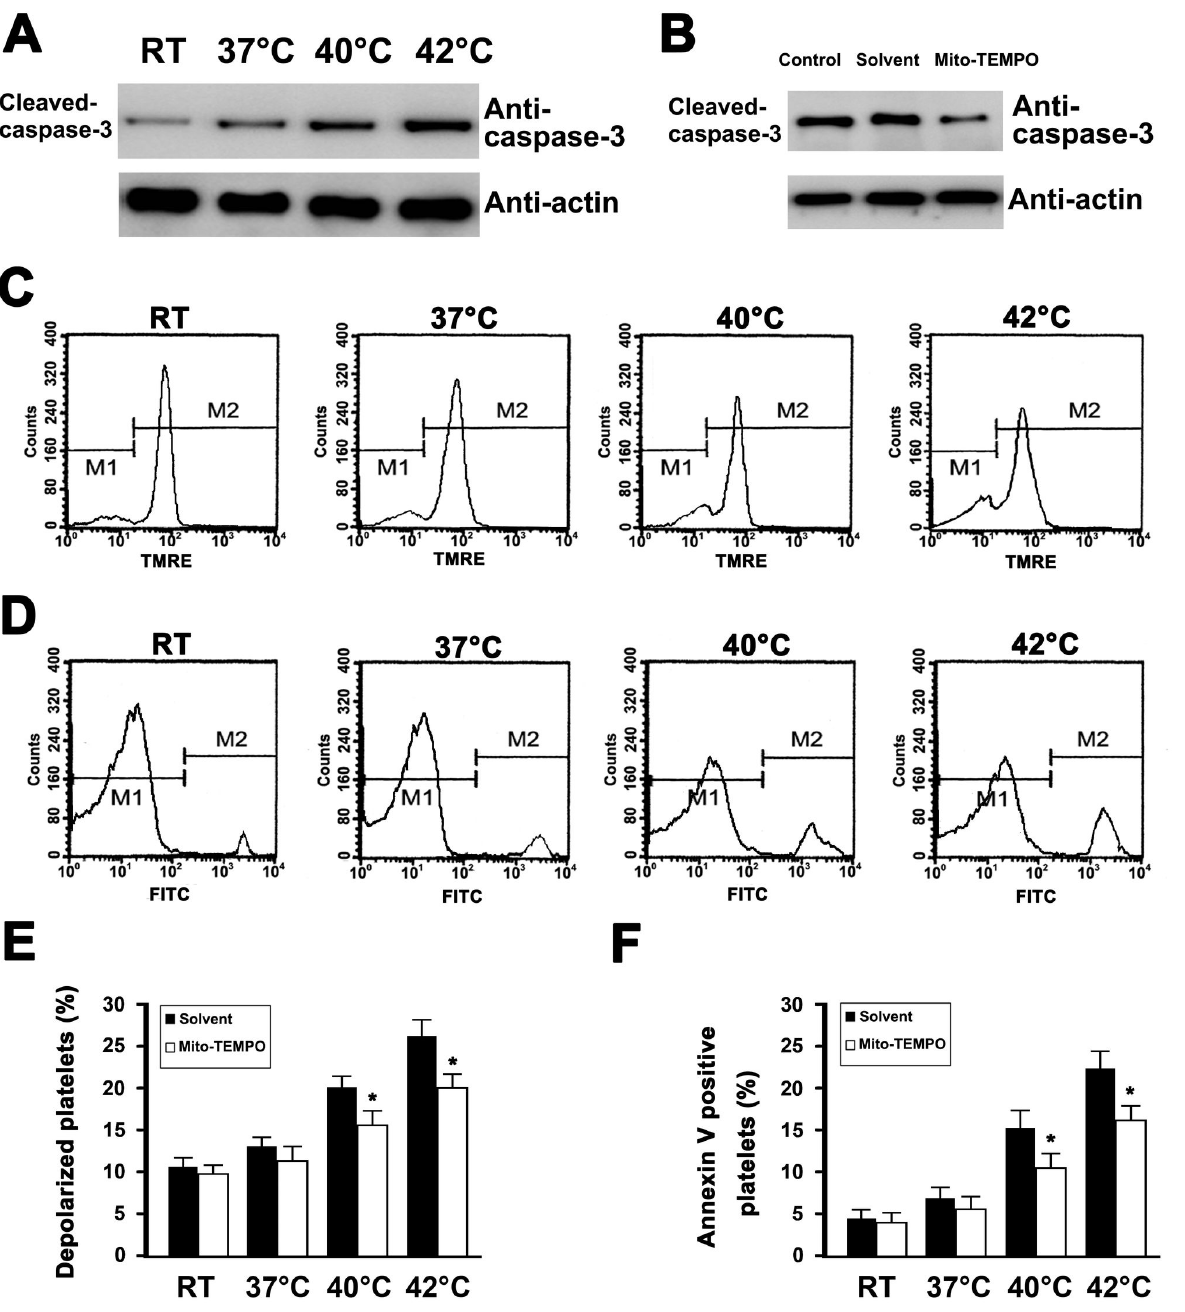
Figure 5. Effect of Mito-TEMPO on caspase-3 activation, depolarization of ΔΨm, and PS exposure in hyperthermia-treated platelets. (A and B) Washed platelets were incubated at indicated temperatures for 3 h (A) or pre-incubated with Mito-TEMPO and solvent control at 37°C for 15 min and then incubated at 42°C for 3 h (B). Treated platelets were lysed and analyzed by Western blot with anti-cleaved p17 fragment of caspase-3. Actin levels were assayed to demonstrate equal protein loading. Representative results of three independent experiments are presented. (C–F) Washed platelets were pre-incubated without (C and D) or with Mito- TEMPO and solvent control at 37°C for 15 min (E and F), and then incubated at the indicated temperature for 3 h. Treated platelets were incubated with TMRE (C and E), or annexin V-FITC (D and F), and analyzed by flow cytometry. Representative flow cytometric histograms are shown (C and D). Data are expressed as a percentage of platelets that were pre-incubated with solvent control at 37°C for 15 min and then incubated at RT for 3 h (E and F). The percentage of RT platelets pre-incubated with solvent is presented as mean ± SEM from three independent experiments. * P <0.05 as compared with solvent control at an identical temperature. doi: 10.1371/journal.pone.0075044.g005 PLOS ONE |